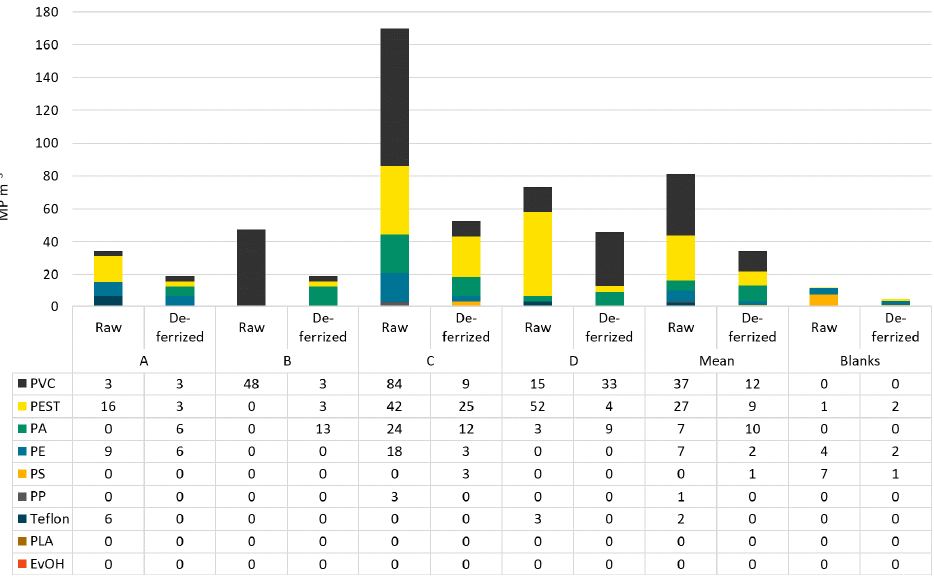
Figure 5. MP types and concentrations in raw and deferrized water from bottlers A–D.